Question: Write a single sentence explaining what this figure depicts.
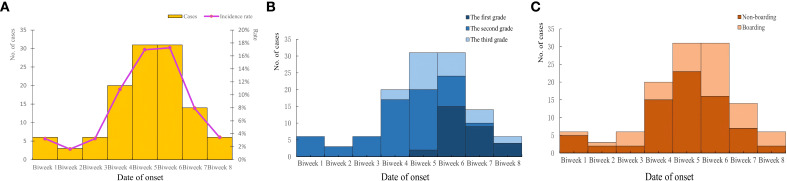
Answer: Temporal distribution of cases by grade and boarding status * (A) Showing incidence rate, (B) Distribution by grade, (C) Distribution by boarding status Biweek 1 (07/23-08/05), Biweek 2 (08/06-08/19), Biweek 3 (08/20-09/02), Biweek 4 (09/03-09/16), Biweek 5 (09/17-09/30), Biweek 6 (10/01-10/14), Biweek 7 (10/15-10/28), Biweek 8 (10/29-11/09).